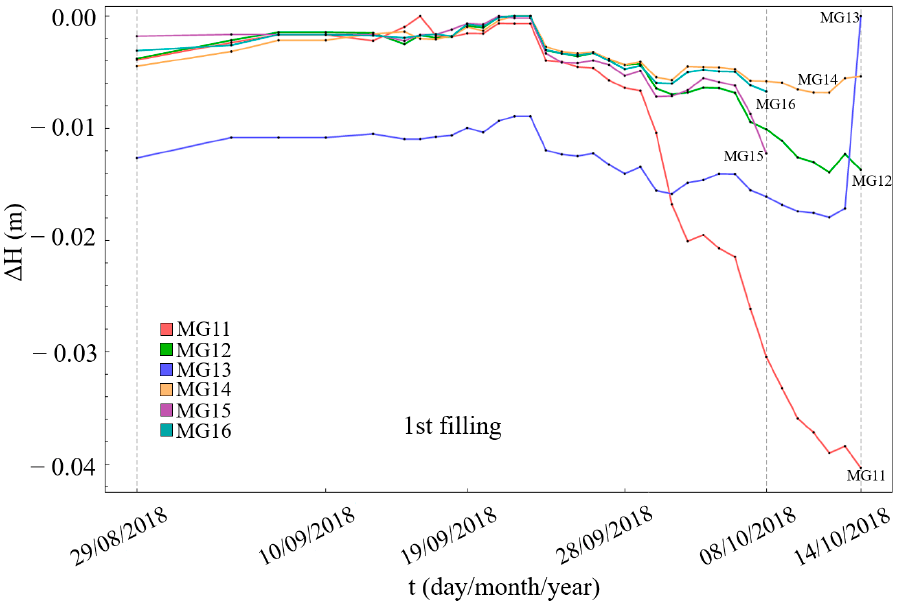
Figure 5. Settlement visualization of points MG11 to M14, from 29 / 08 / 2018 to 14 / 10 / 2018, and of points MG15 and M16, from 29 / 08 / 2018 to 08 / 10 / 2018. Table 1. Height values of points MG1 to MG16, relating to the start and end time of monitoring during the first filing of the reservoir.